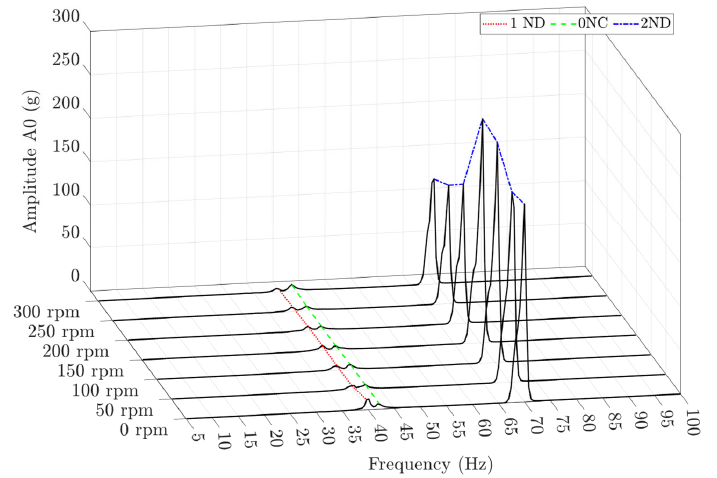
Figure 12. Maximum spectra of the STFT of the on-board accelerometer when the disk was excited in air with a chirp in the range of 0 to 100 Hz at different rotating speeds.